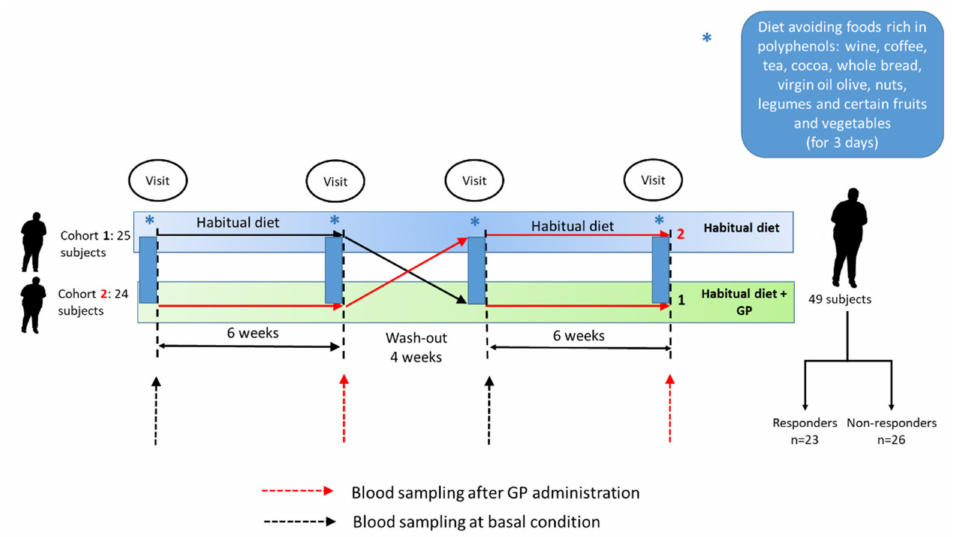
Figure 1. Experimental design of the randomised cross-over clinical trial. GP: grape